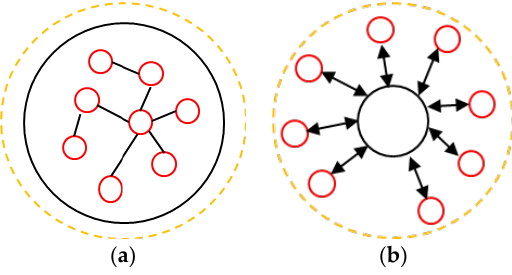
Figure 1. Different modelling approaches for sector coupling (SC) analyses, comprising: a closed model environment ( a ); and open model environment ( b ).